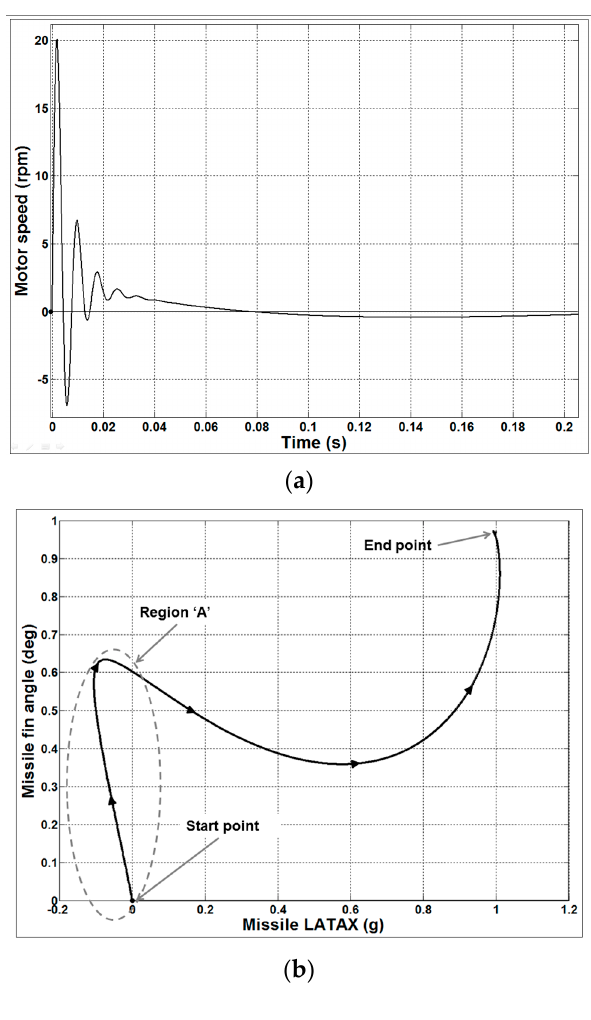
Figure 10. Cont. Figure 10.